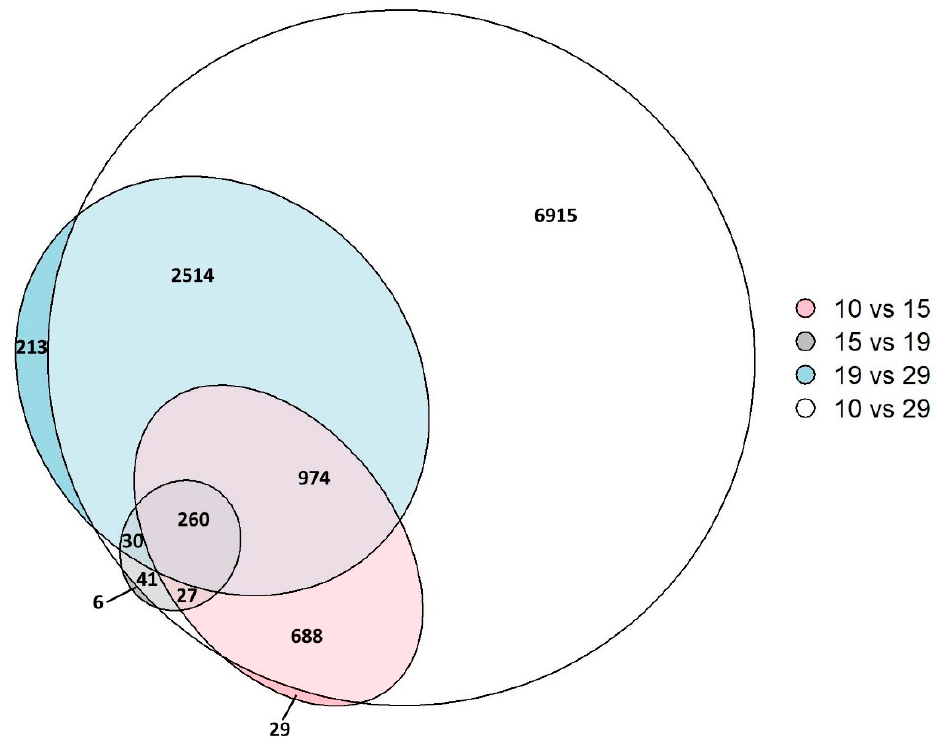
Figure 2. Number of DEGs between time points. A Venn diagram depicting the number of genes that are differentially expressed between neighbouring time points and/or between 10 and 29 dap, as well as the intersection between them. For example, there are 6915 genes differentially expressed only between 10 vs. 29 dap, and there are 2514 genes differentially expressed between both 10 vs. 29 dap and 19 vs. 29 dap. Due to the nature of area-proportional Venn diagrams, not all DEGs are shown, as the image is a visual approximation. Thus, although it is not depicted, there is also a single gene differentially expressed between both 10 vs. 15 dap, and 15 vs. 19 dap.